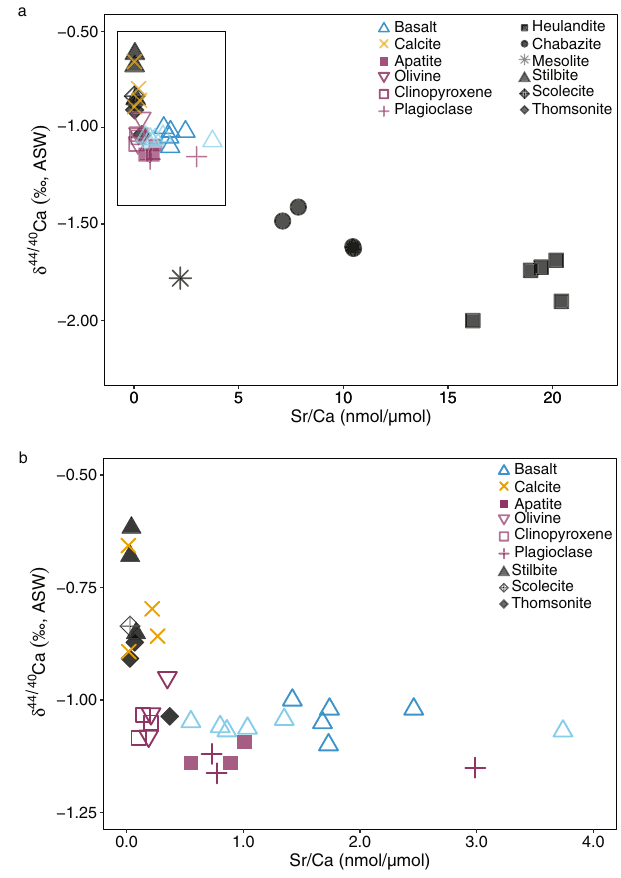
Fig. 3 δ 44/40 Ca versus Sr/Ca for primary minerals, bulk basalt, calcite, and zeolites. a Ca isotope measurements of all samples. Symbol size is larger than the external reproducibility (±0.05 ‰ , 2 σ SD ). b Inset from panel ( a ) includes basalt from the Berufjörður – Breiðdalur region (dark blue triangles), as well as basalt from previous studies (light blue triangles) 21